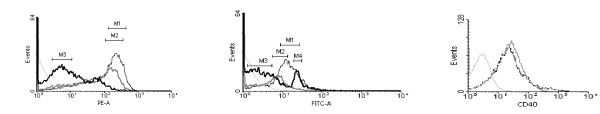
Effect of alcoholic ginger extract on costimulatory molecule expression on murine peritoneal macrophage. Peritoneal macrophages from C57Bl/6 mouse were isolated and stimulated with 100 ng/ml LPS in presence or absence of ginger extract for 24 h. The cells were harvested and stained with fluorophore conjugated mAb against B7.1 (A), B7.2 (B) and CD40 (C) and analyzed in LSR II flow cytometer. Data are representative result of six replicates.